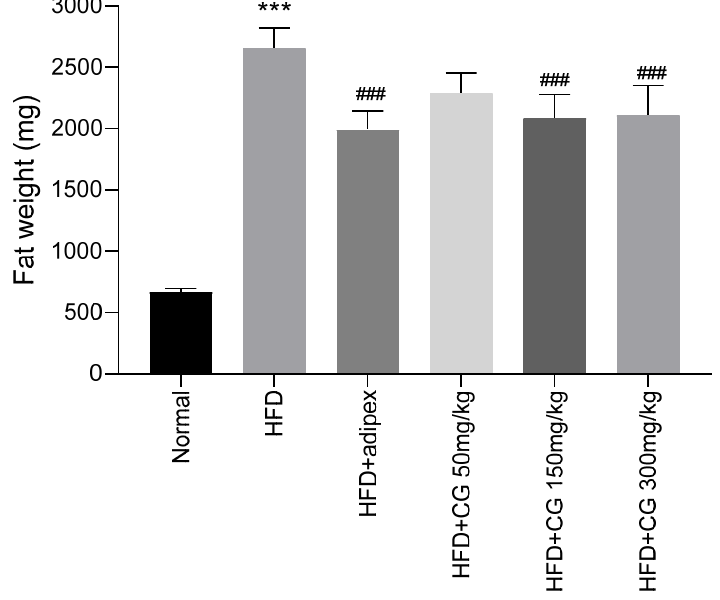
Figure 3. Effect of chitoglucan on fat weight. Data represent means ± S.E.M. *** p < 0.001 compared with Normal group, ### p < 0.001 compared with HFD group. with Normal group, ### p < 0.001 compared with HFD